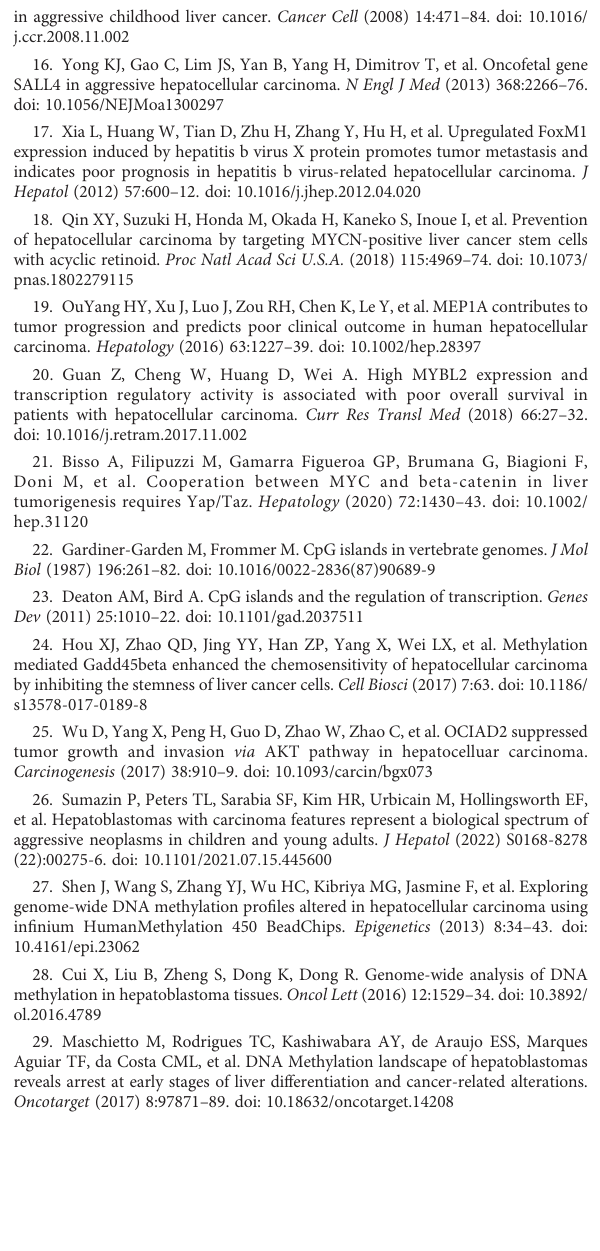
SUPPLEMENTARY FIGURE S7 Kaplan-Meier plots of the overall survival of HCC patients between higher and lower gene expression levels of 4 differentially expressed genes identi fi ed in HCN-NOS. The horizontal axis represents the overall survival time in days and the vertical axis represents overall survival probability. Higher gene expression levels of COL2A1 (A) , MYCN (B) , MYBL2 (C) and E2F1 (D) were all associated with lower overall